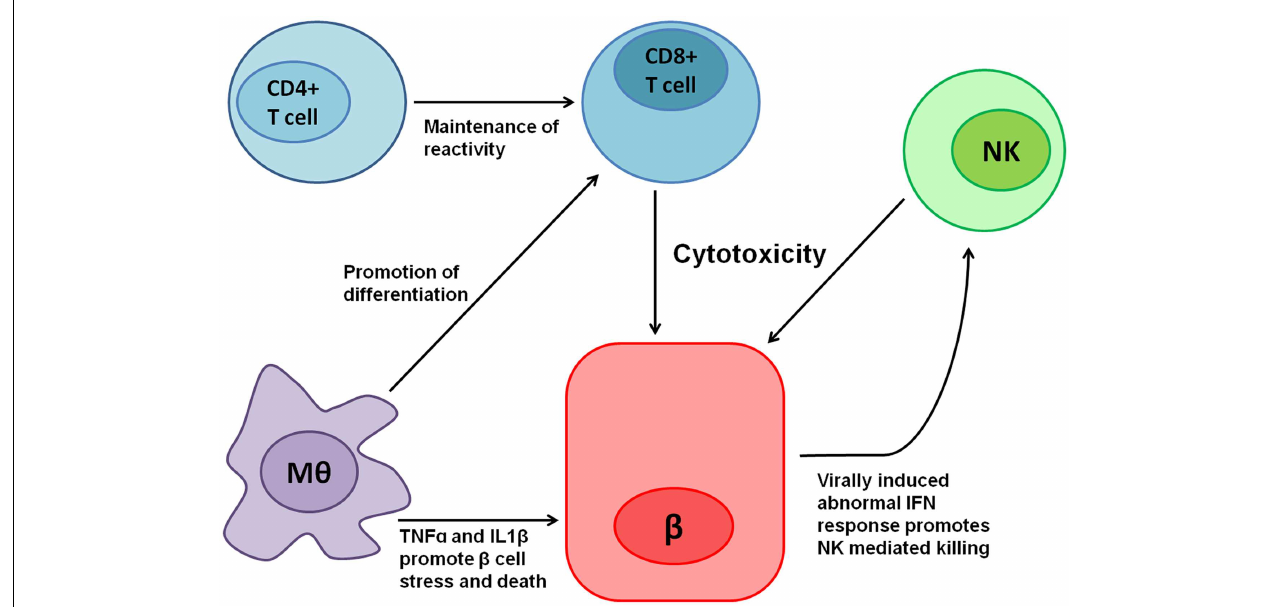
interactions and in Trans by cytokines. Local inflammation, β cell stress, and the expression of an unknown ligand for NKp46 contribute to NK cell reactivity toward β cells, which have been shown to kill β cells. In addition, β cells have been shown to exhibit abnormal interferon (IFN) responses when infected by viruses (64), thus potentially contributing even further to NK mediated